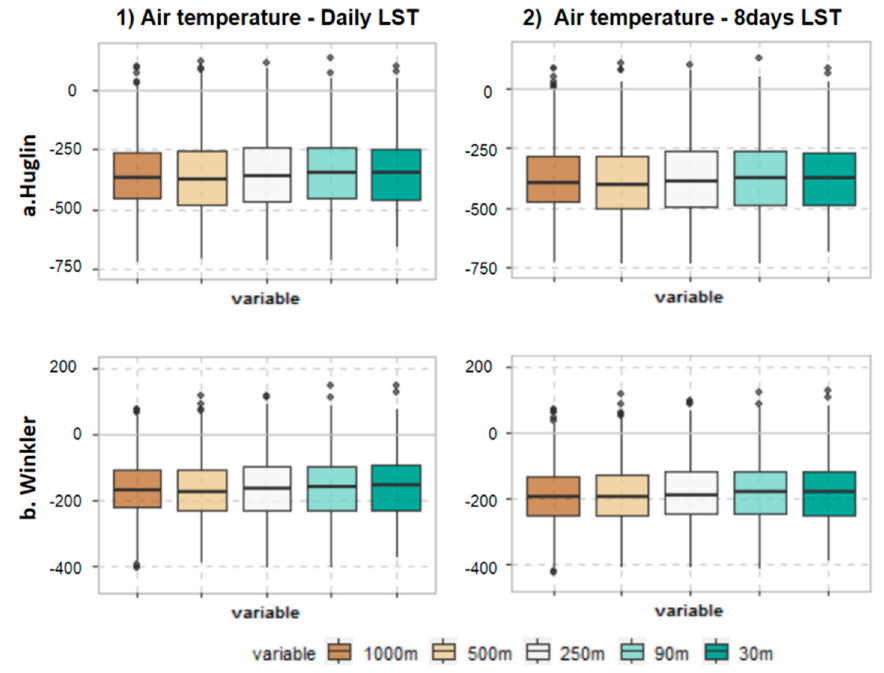
Figure 9. Distribution of differences (°C) between (1) daily air temperature and daily LST and (2) daily air temperature and 8days LST using to calculate the ( a ) Huglin and ( b ) Winkler bioclimatic indices at different spatial resolutions.